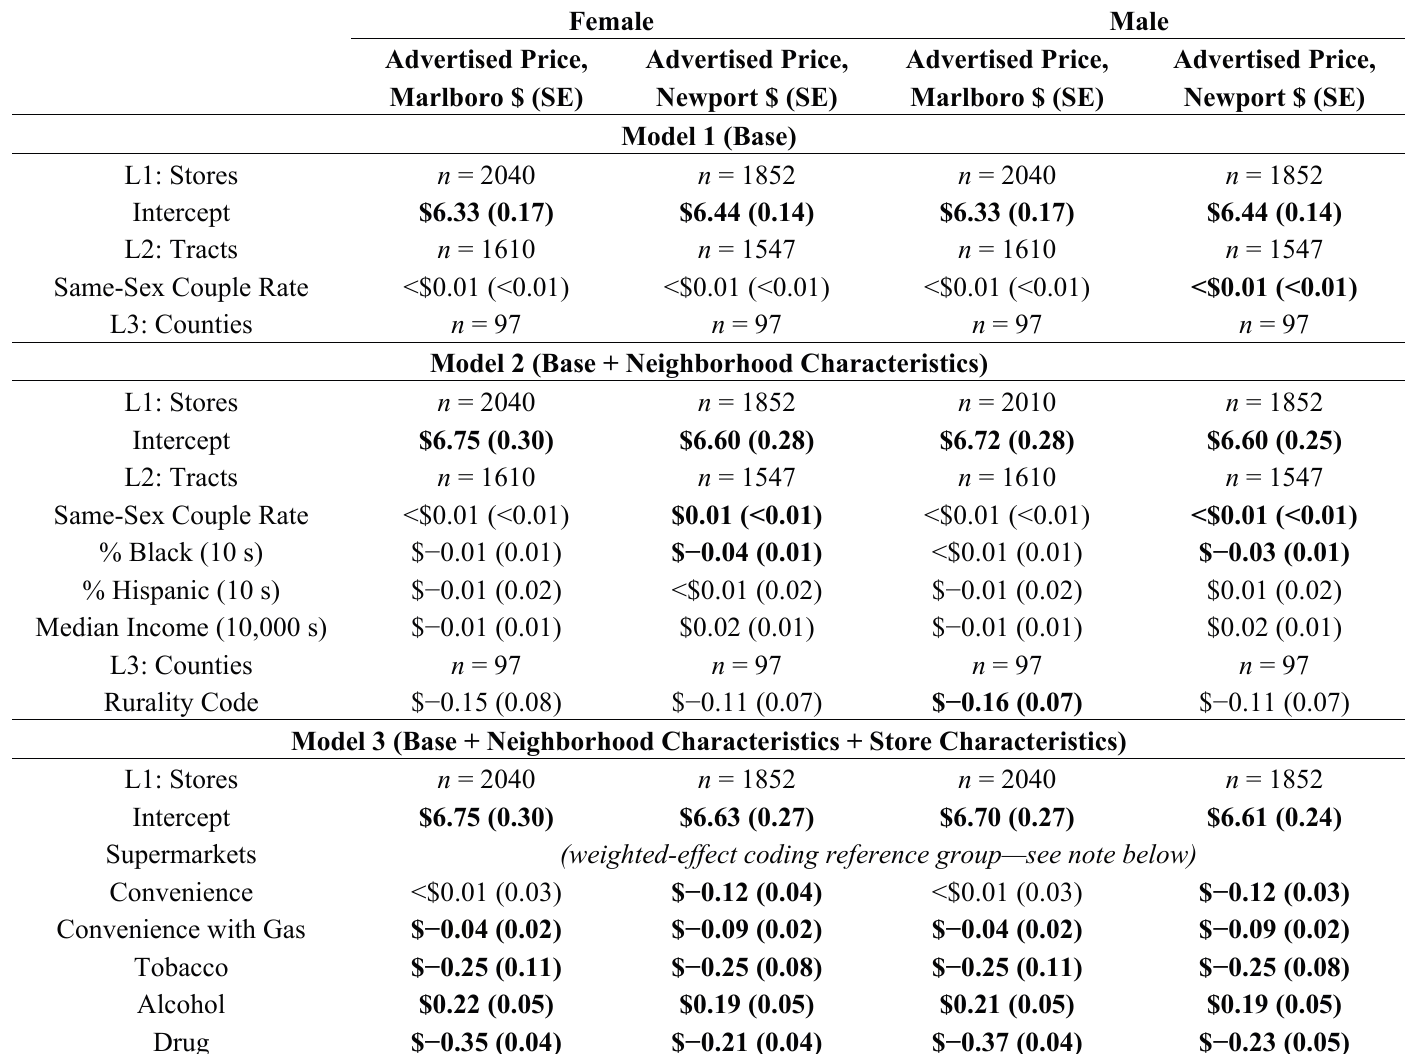
Table 5. Three-level models associating same-sex couple rate with retailer tobacco marketing characteristics (97 counties,